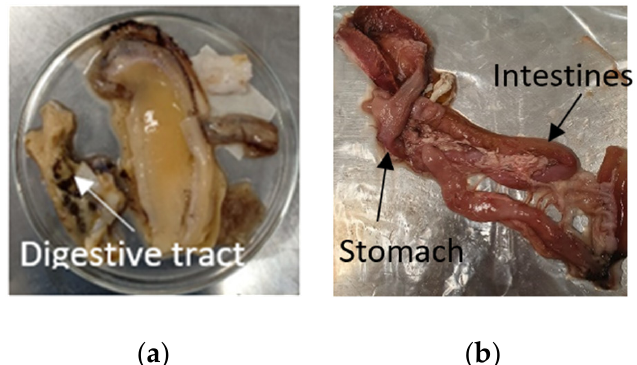
Figure 1. Digestive tracts from ( a ) NZ green-lipped mussel and ( b ) tarakihi fish, obtained at T = room temperature.